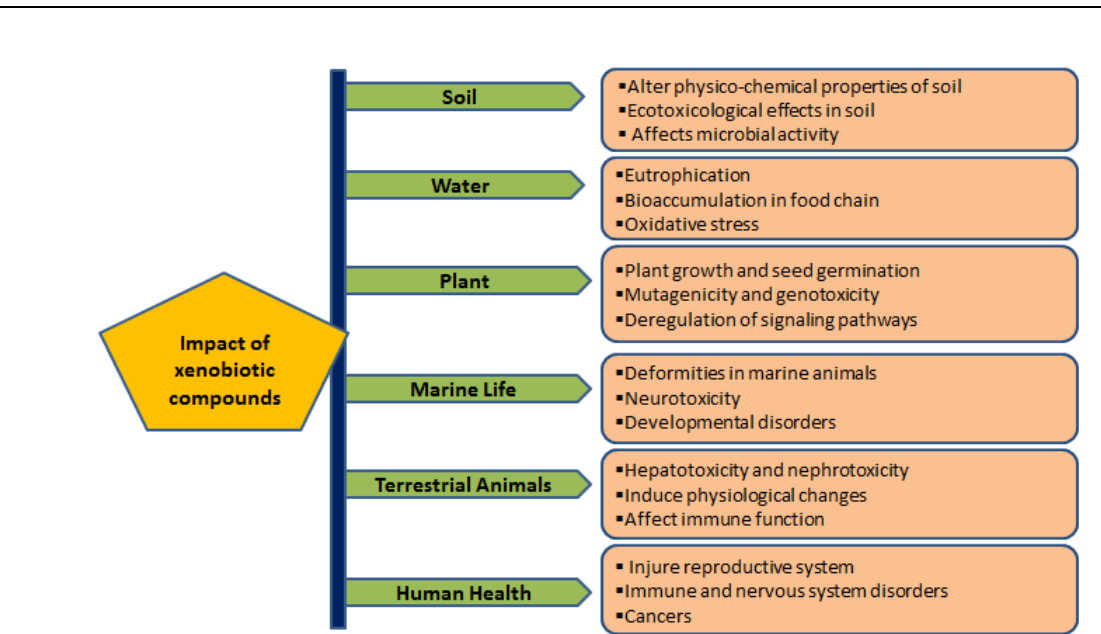
Figure 1. Hazardous effects are caused by direct or indirect exposure of xenobiotic compounds on the environment, plants, animals and human health. Xenobiotics impose ecotoxicological effects on soil organisms, reduce microbial activity, and change the soil’s physico-chemical properties. Releasing xenobiotic compounds to aquatic systems (fresh and marine water) causes eutrophication and severe threats to faunal diversity, including deformities and developmental disorders. In addition, continuous exposure to xenobiotics adversely affects the immune, reproductive and nervous systems and sometimes causes various